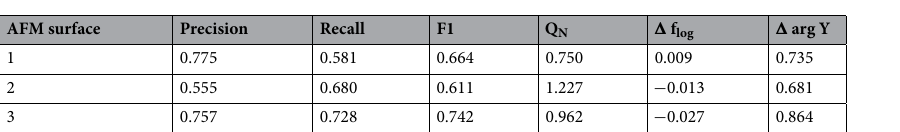
Table 3. Defect detection accuracy of the test AFM images and the resulting differences between EIS spectra of true and predicted defect sets.